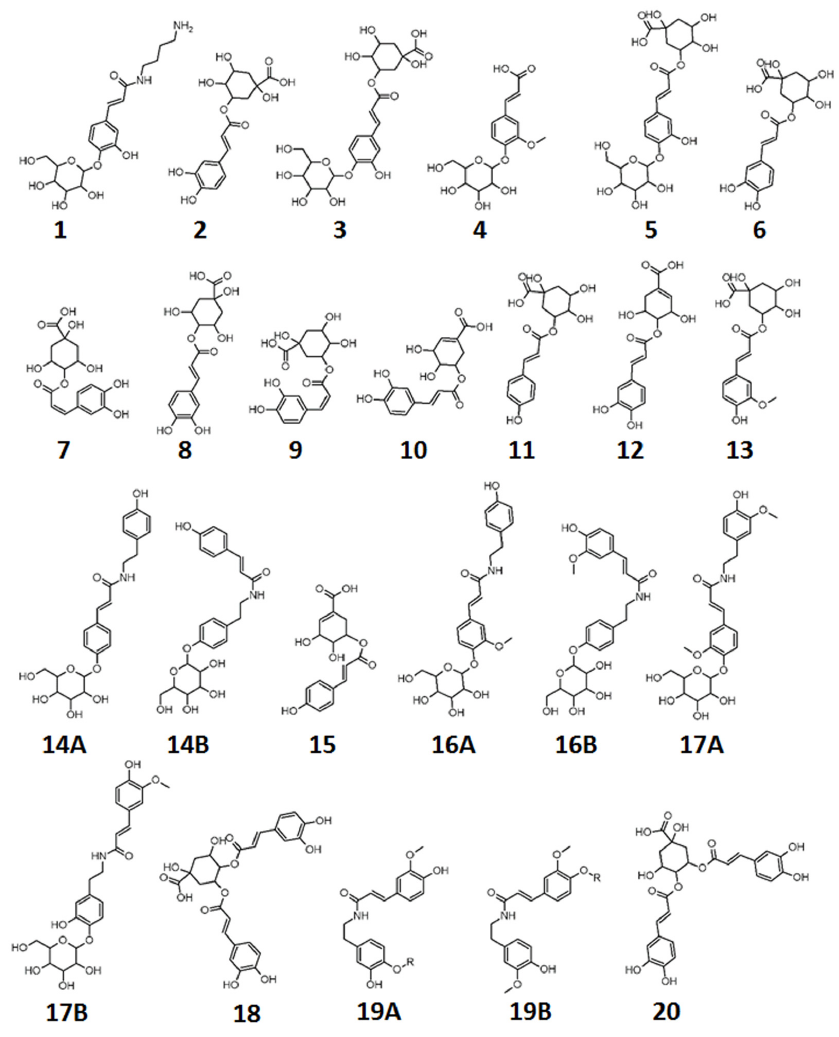
Fig 4. Structures of identified metabolites comprising the signatory biomarkers of the priming response of tobacco cells towards LPS, CHT and FLG. R represents unknown molecules attached to the identified: R = 204